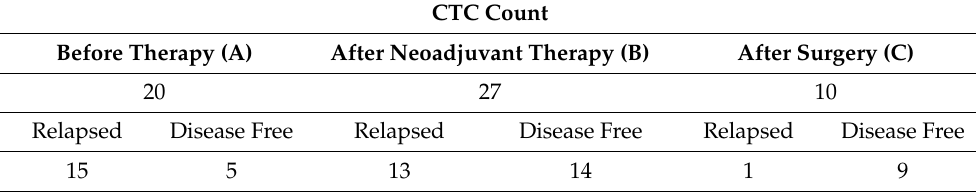
Table 1. CTC counts during patients’ treatment course and clinical outcomes (relapsed or disease free). Blood draws were performed before therapy (A), one month after the end of neoadjuvant therapy (B) and one month after surgery (C). The second and the third blood draws were performed concomitantly to CT scan.